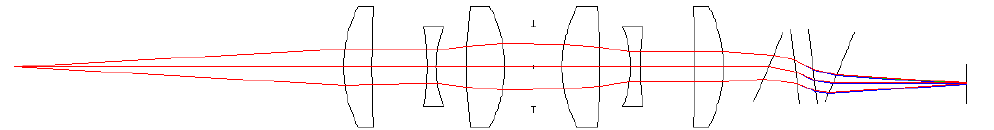
Figure 5. Ray diagram of the Dual-Prism Coded Aperture Snapshot Spectral Imager simulated by the OSLO lens design software.